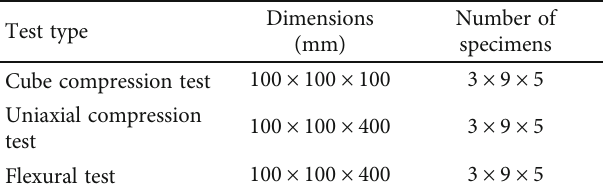
Table 3: Test type and specimen